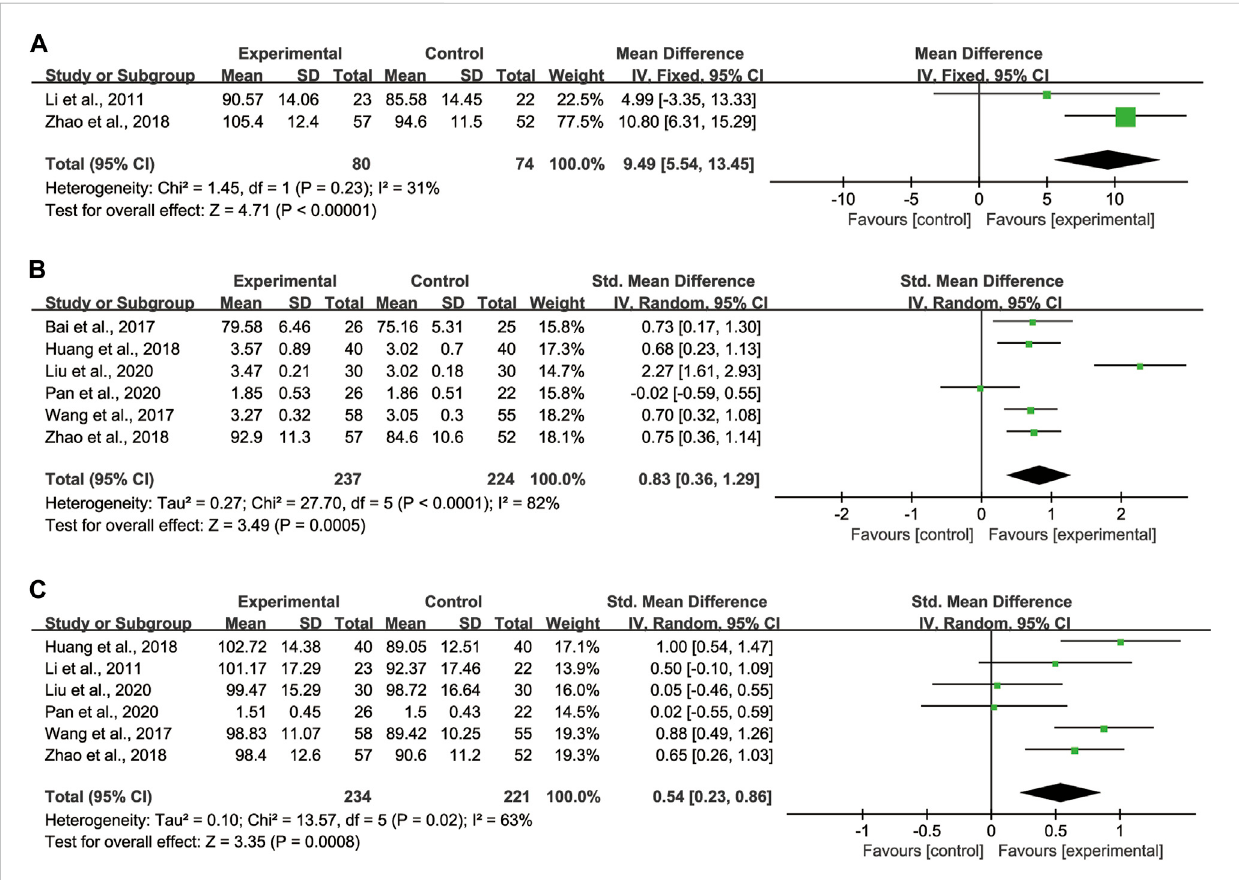
FIGURE 4 Forest plot of lung function: CHMs plus CTX treatment versus CTX treatment. (A) VC, (B) FVC, (C)